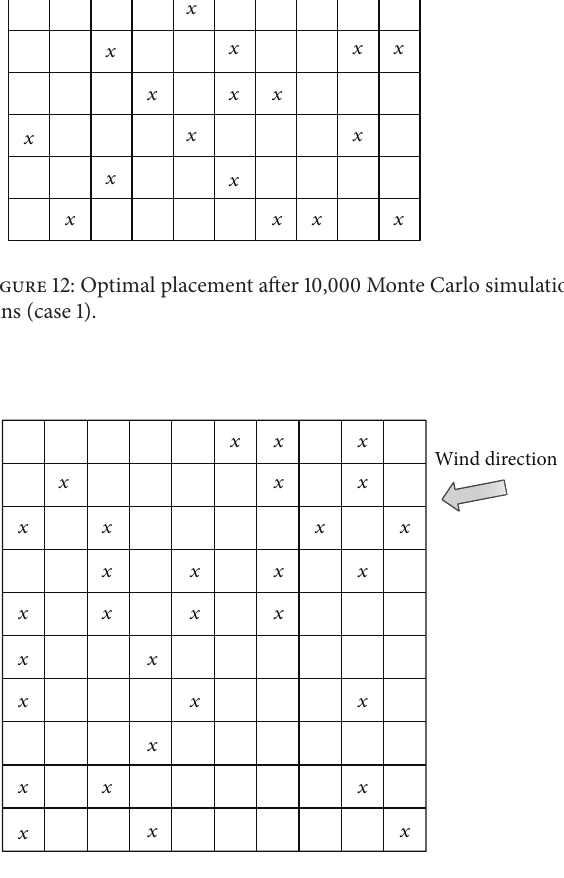
Figure 13: Optimal placement after 10,000 Monte Carlo simulation runs (case